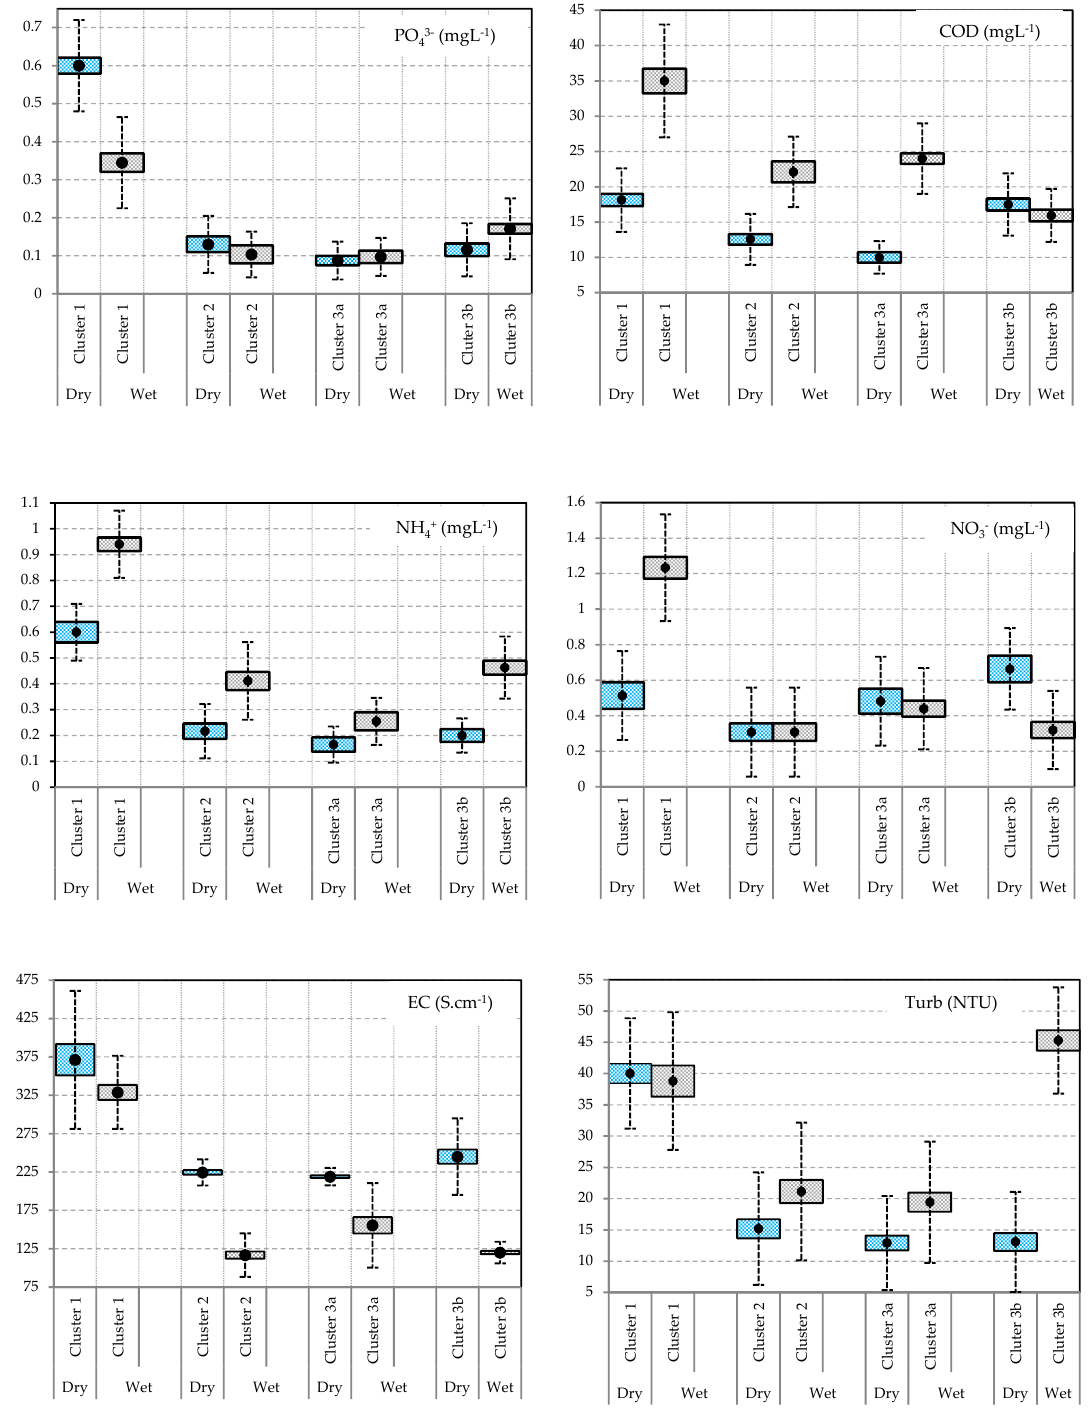
Figure A1. Di ff erent spatial distributions of water quality between dry and wet Figure A1. Different spatial distributions of water quality between dry and wet seasons.